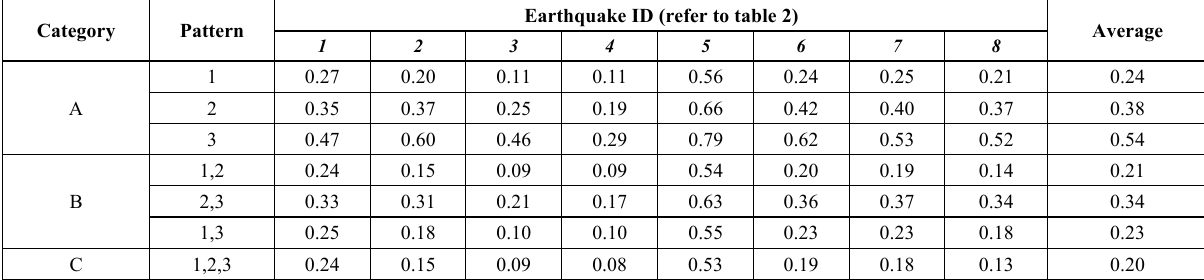
TABLE III. Earthquake ID (refer to table 2)